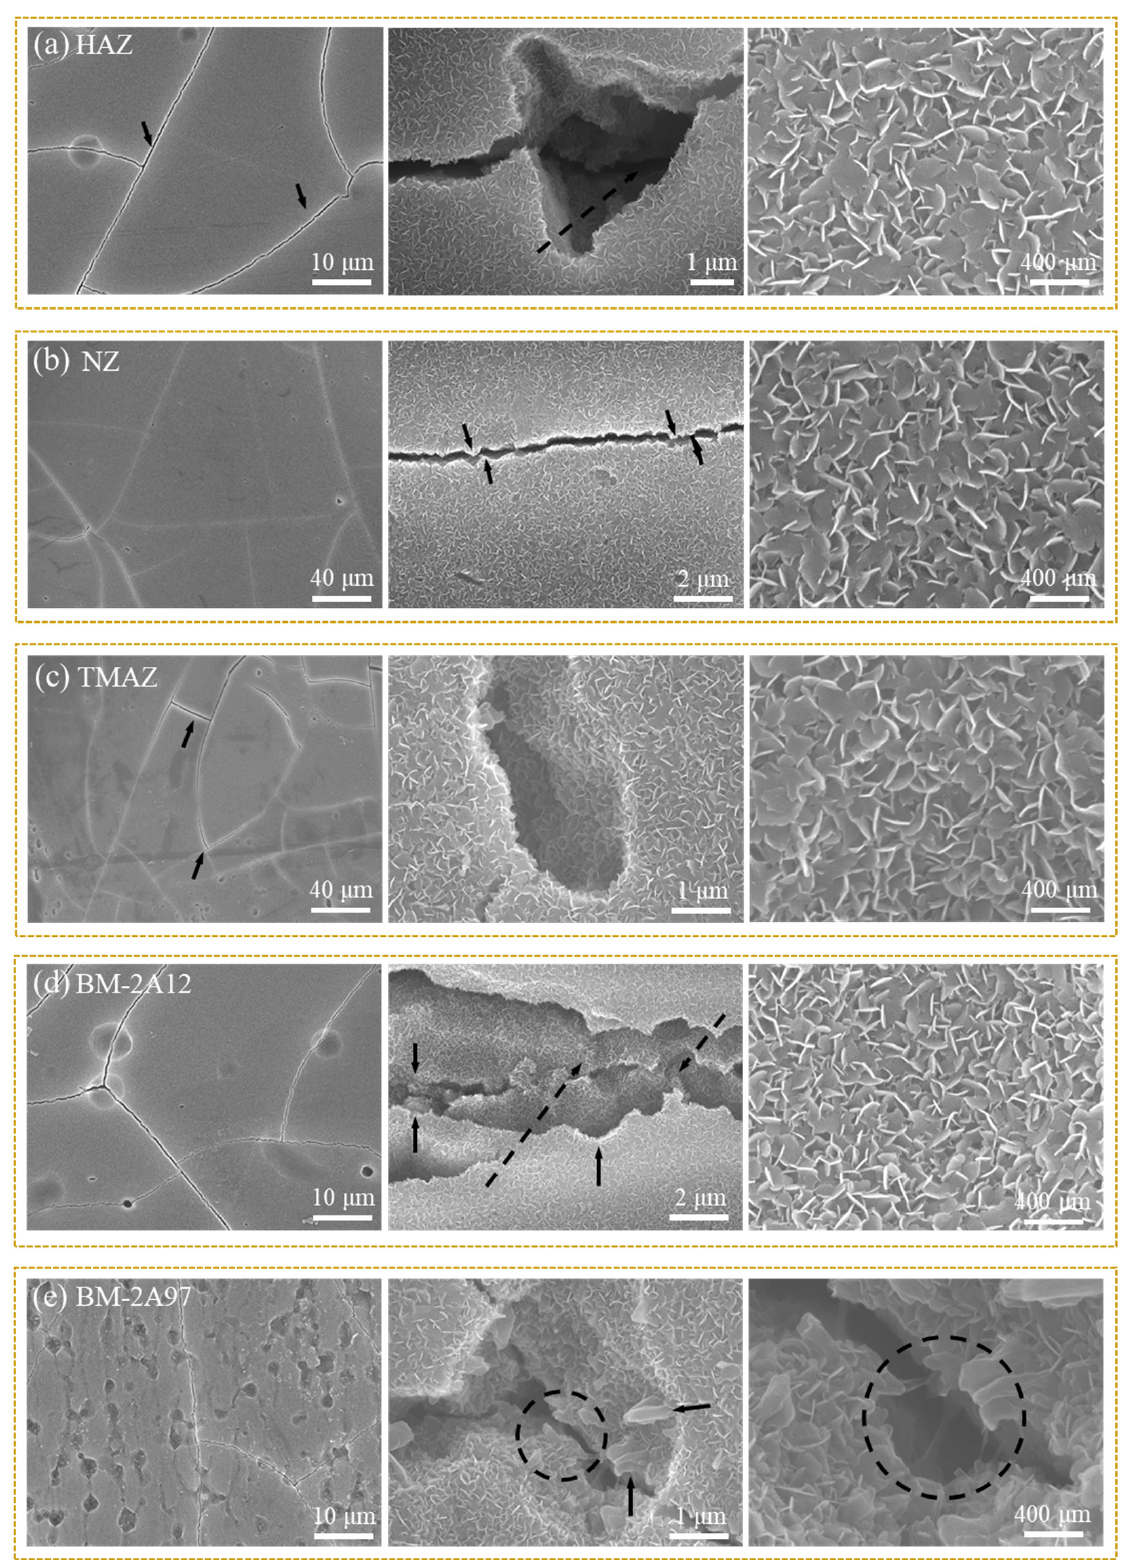
Figure 5. SEM images of the CSA-LDH-PF film on different FSW joint areas. ( a ) HAZ, ( b ) NZ, ( c ) TMAZ, ( d ) BM-2A12 and ( e ) BM-2A97.